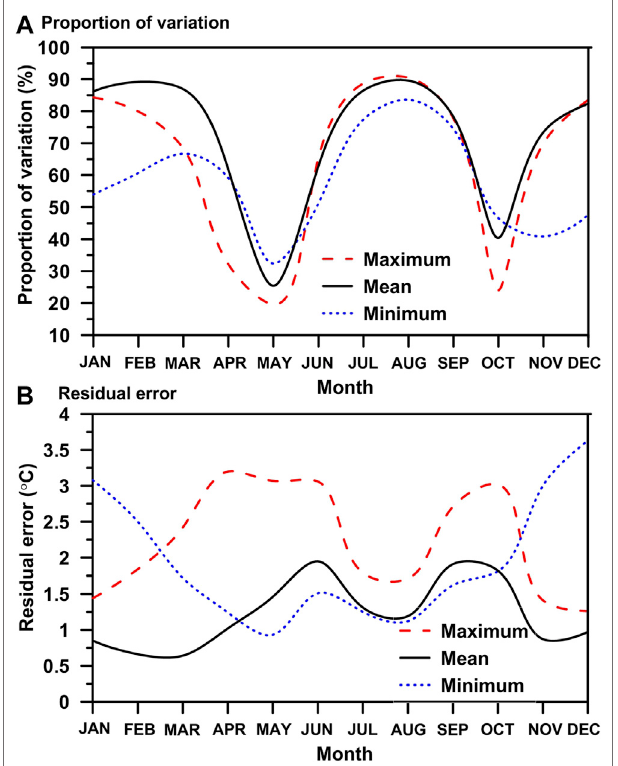
FIGURE 4 | Annual variation in the proportion of variation (A) and residual error (B) resulting from multi-coolinearity assessment.